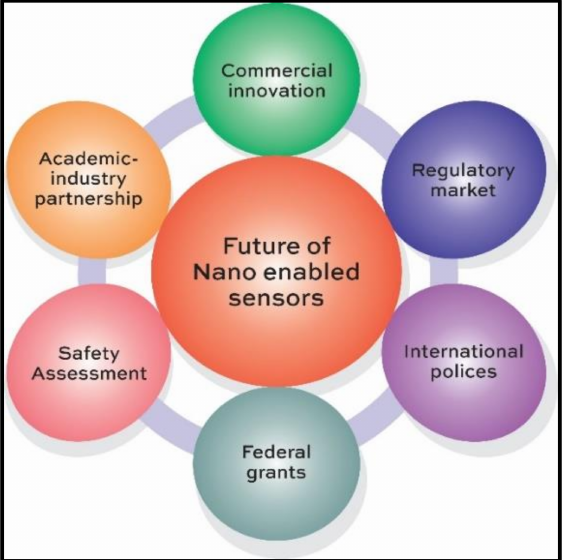
Figure 19. Factors affecting the future development of nano-enabled sensors.